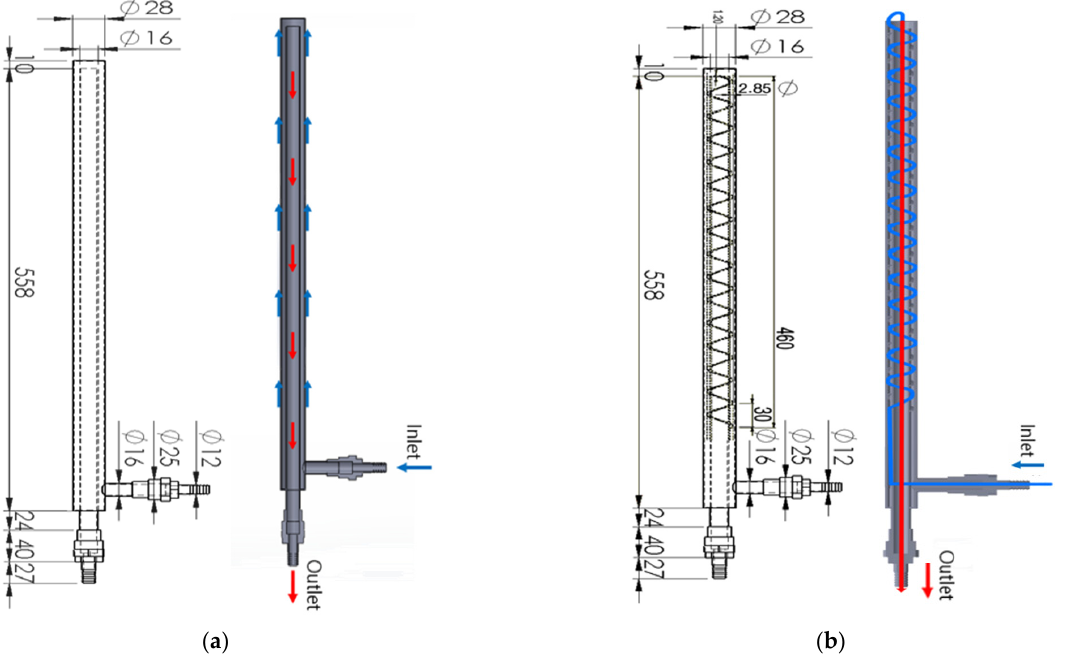
Figure 2. Detail of existing absorber tube with and without coil. ( a ) Absorber tube without coil; ( b ) Absorber tube with coil.